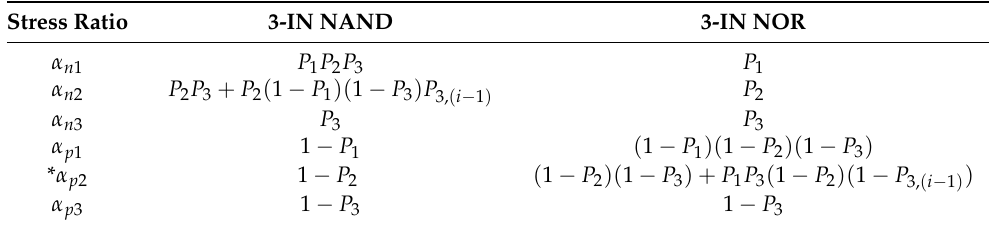
Table 3. Stress table for 3-in basic gates at clock cycle i as a function of the input signal probabilities. Stress Ratio 3-IN NAND 3-IN NOR α n 1 P 1 P 2 P 3 P 1 α n 2 P 2 P 3 + P 2 ( 1 − P 1 )( 1 − P 3 ) P 3, ( i − 1 ) P 2 α n 3 P